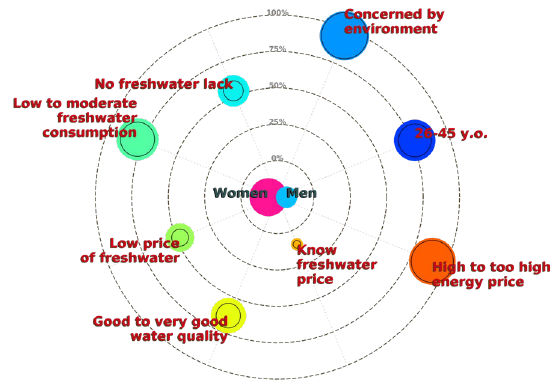
Figure 6. The highlight of the data collection main output linked with participant gender, concentric circles indicate the percentage of women agree with that assertion By order of concern, participants indicated that climate is first followed by energy and freshwater. Up to 79% of the participants consider that their water consumption is moderate to low, 63% think that water quality is "good" to "very good" but only 10% of the participants gave an acceptable range of freshwater price with 60% who clearly said they do not know. Energy seems more important than water for most of the participants; they have a better understanding of energy price and usage. That point of view can be explained by the large needs